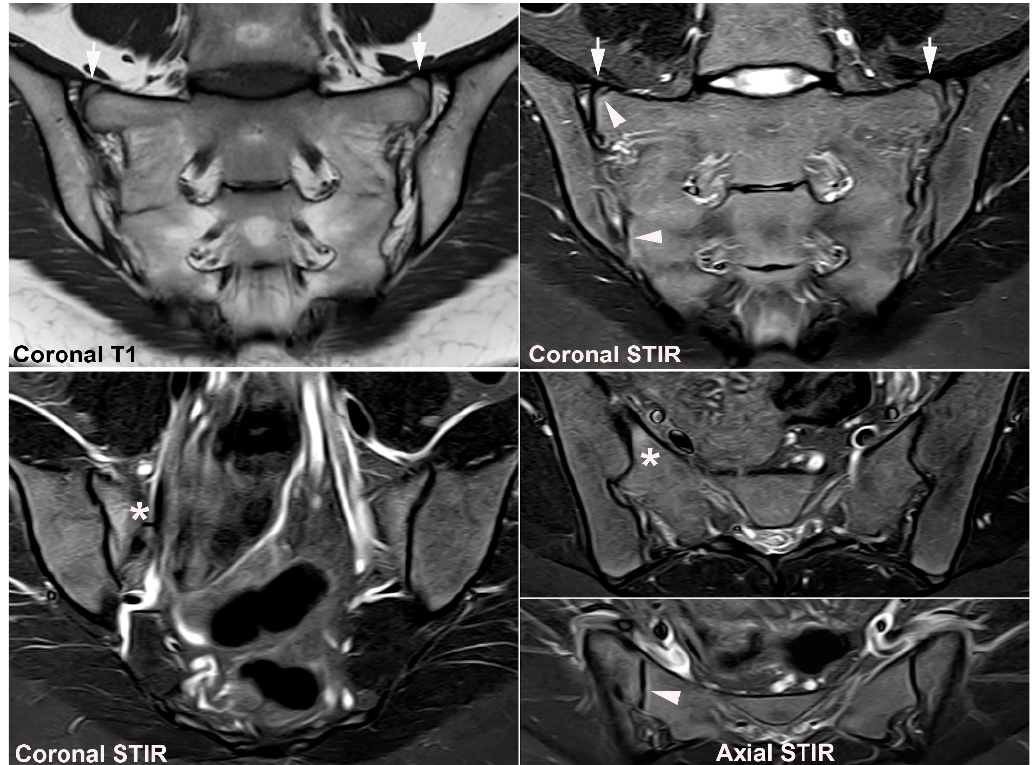
Figure 4. Normal SIJ in a 17-year-old girl. Upper row of images: semi-coronal T1 and STIR images posteriorly at the sacral wings; lower row: semi-coronal STIR more anteriorly at the border between S1 and S2, and two semi-axial STIR images, one at the level of S1/S2 (upper image) and one at the inferior part of S2. There is still a symmetrical subchondral brim of edema in the sacrum (arrowheads) in addition to persistence of unfused nuclei at the sacral wing (arrows) with a brim of adjacent edema, most pronounced at the right side (arrowhead). The nuclei between S1 and S2 have fused with the sacrum, but there is persistence of edema adjacent to the nucleus area on the right side (asterisk), which must not be mistaken for inflammatory changes.